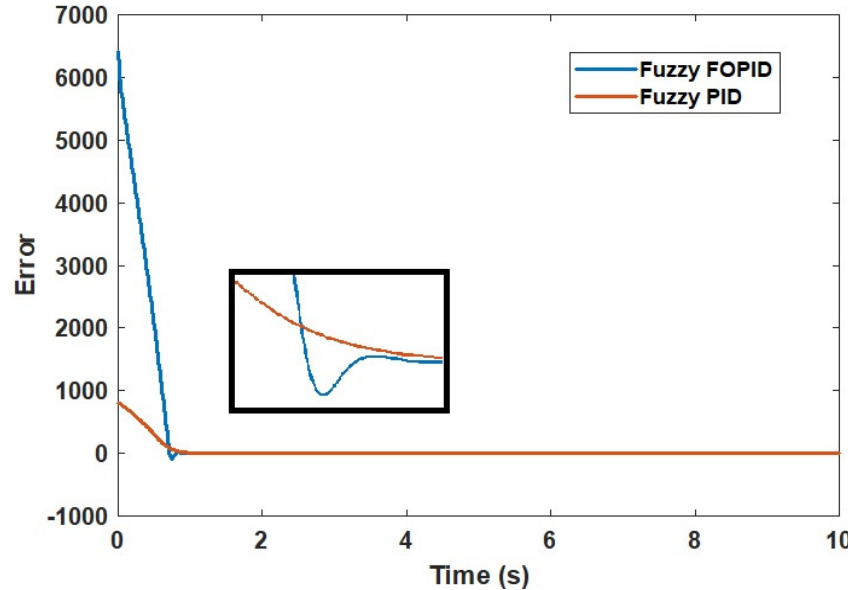
Figure 20. Control signal of the fuzzy FOPID and PD fuzzy.